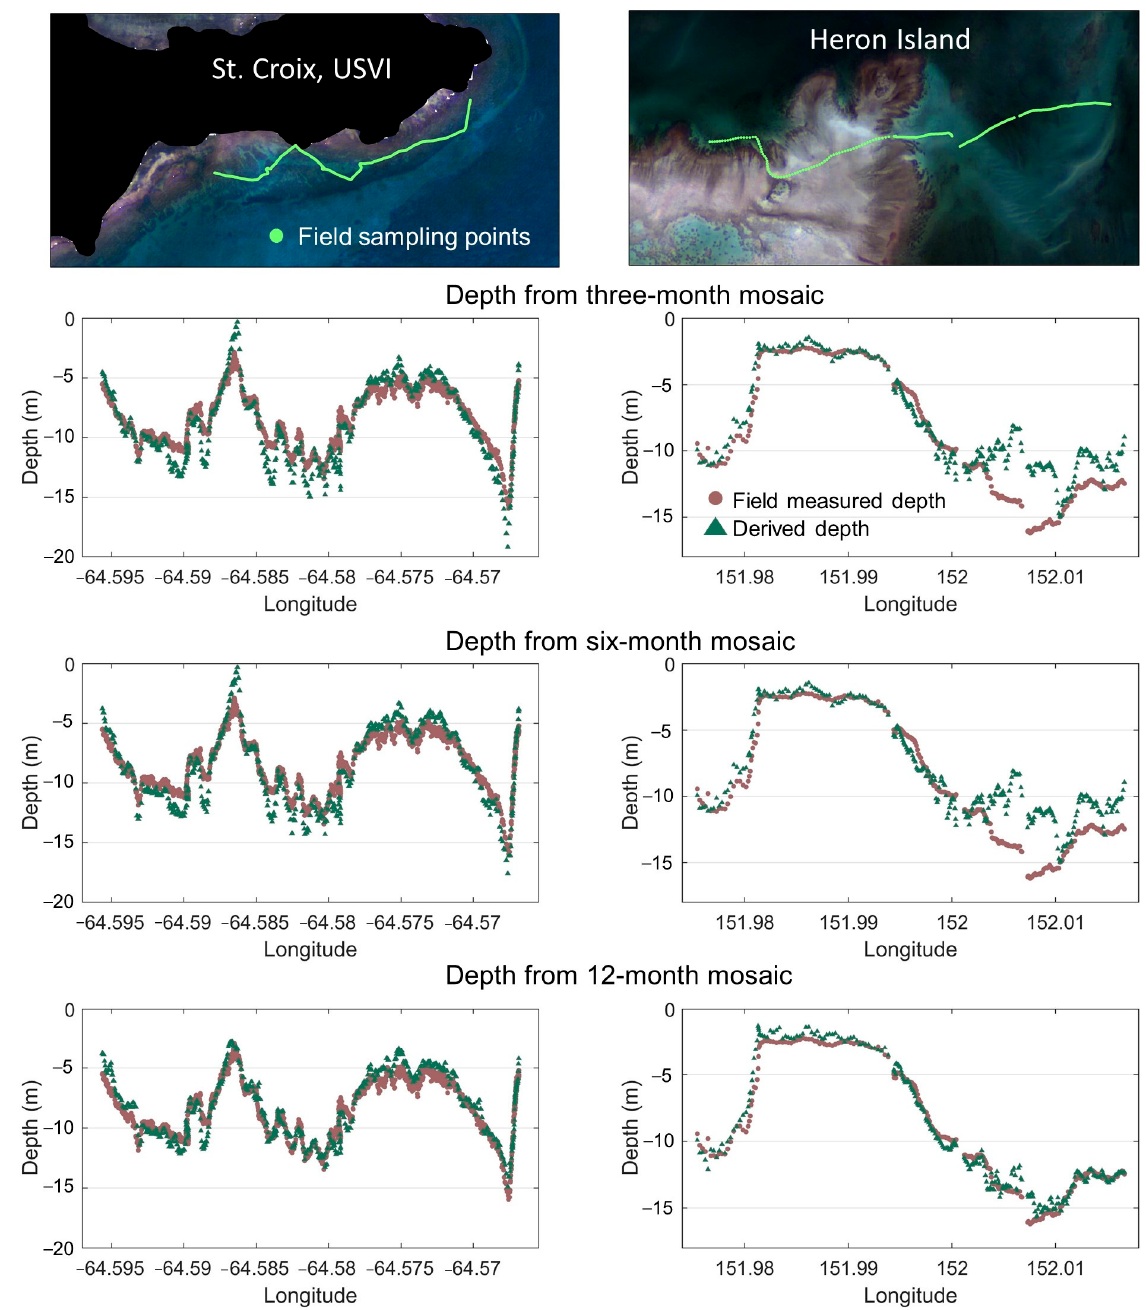
Figure 8. Comparisons between Google Earth Engine derived depth with field measured depth at St Croix, USVI, and Heron Island, Australia. The 12-month mosaic offered better bathymetry results than the three-month and six-month mosaics.